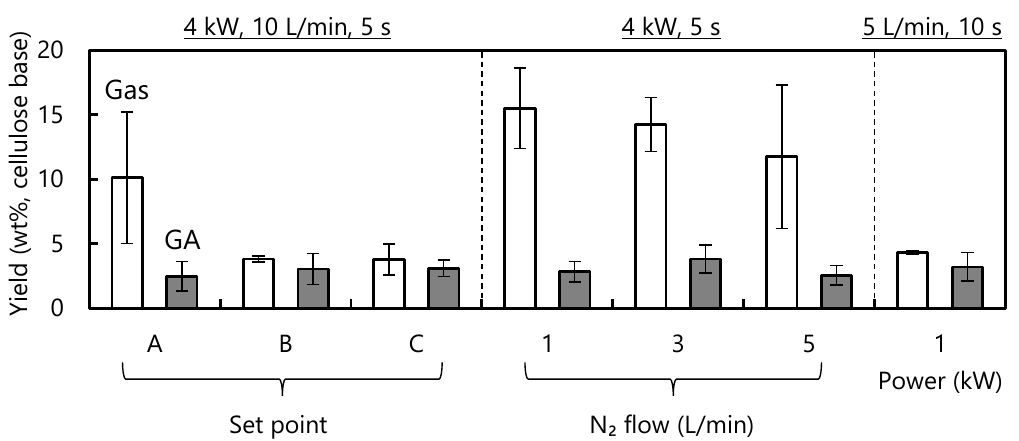
Figure 6. Yields of glycolaldehyde (GA) and overall gas yields (wt % based on amount of cellulose) from the pyrolysis of Whatman cellulose under various conditions.